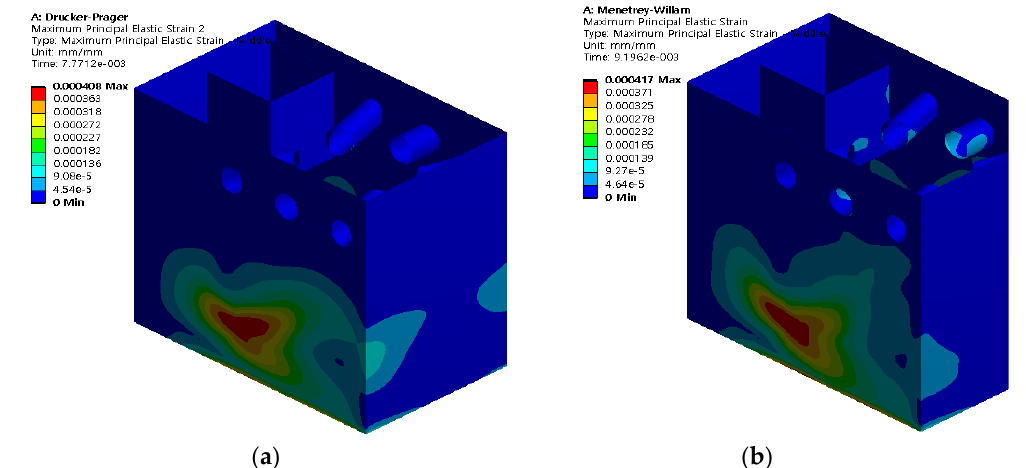
Figure 10. Von Mises stress distribution in the liner plate. ( a ) The Drucker-Prager model. ( b ) The Menetrey-William model.